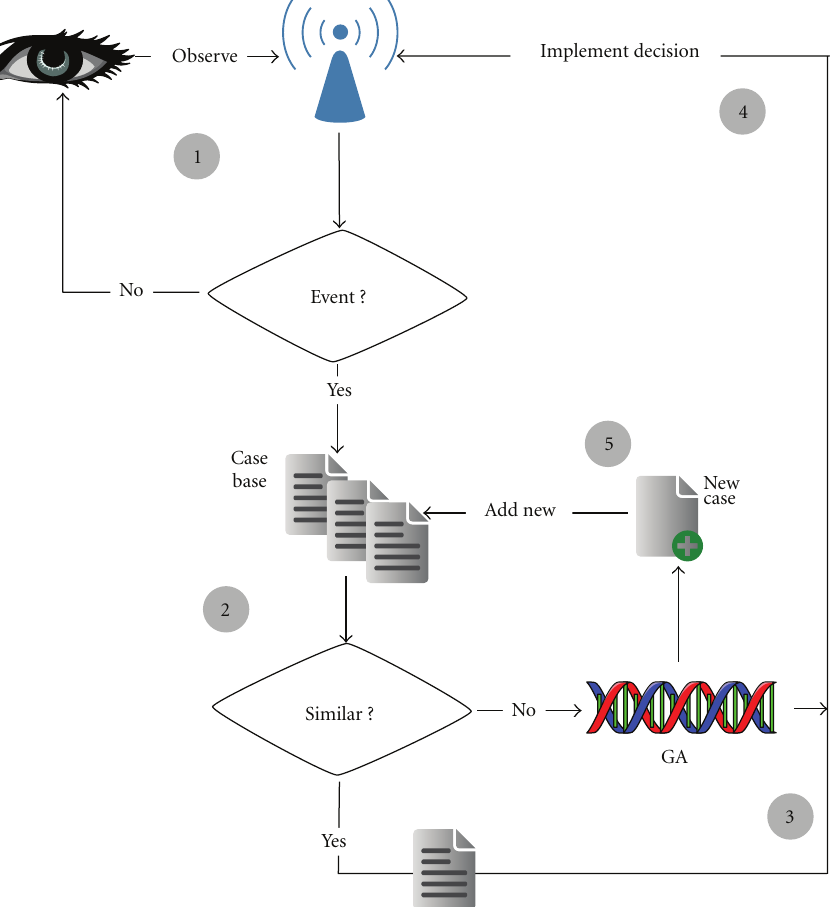
Figure 1: Hybrid CBR-GA cognitive engine process